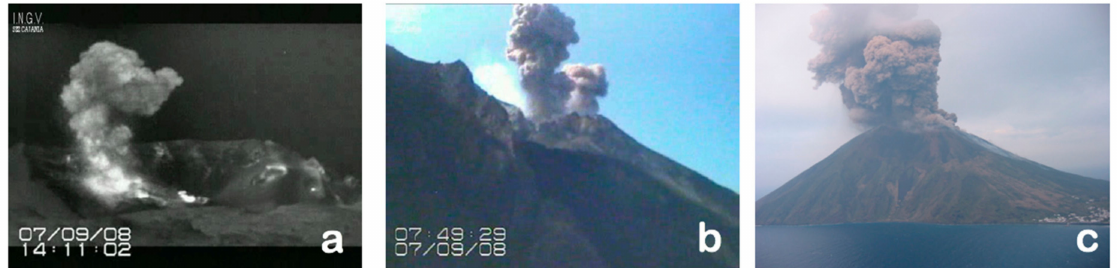
Figure 2. ( a ) Ordinary Strombolian explosion from the SWC producing an ash plume ~80 m high, recorded by the SPI infrared camera located at Il Pizzo Sopra La Fossa on 7 September 2008, view from South. ( b ) Image from the SQV camera showing the eruptive ash column rising ~300 m above the craters during the major explosion of 7 September 2008, view from NE. ( c ) Photo taken from helicopter by S. Calvari during the 5 April 2003 paroxysm, showing the eruptive column rising > 1 km above the summit of the volcano, view from